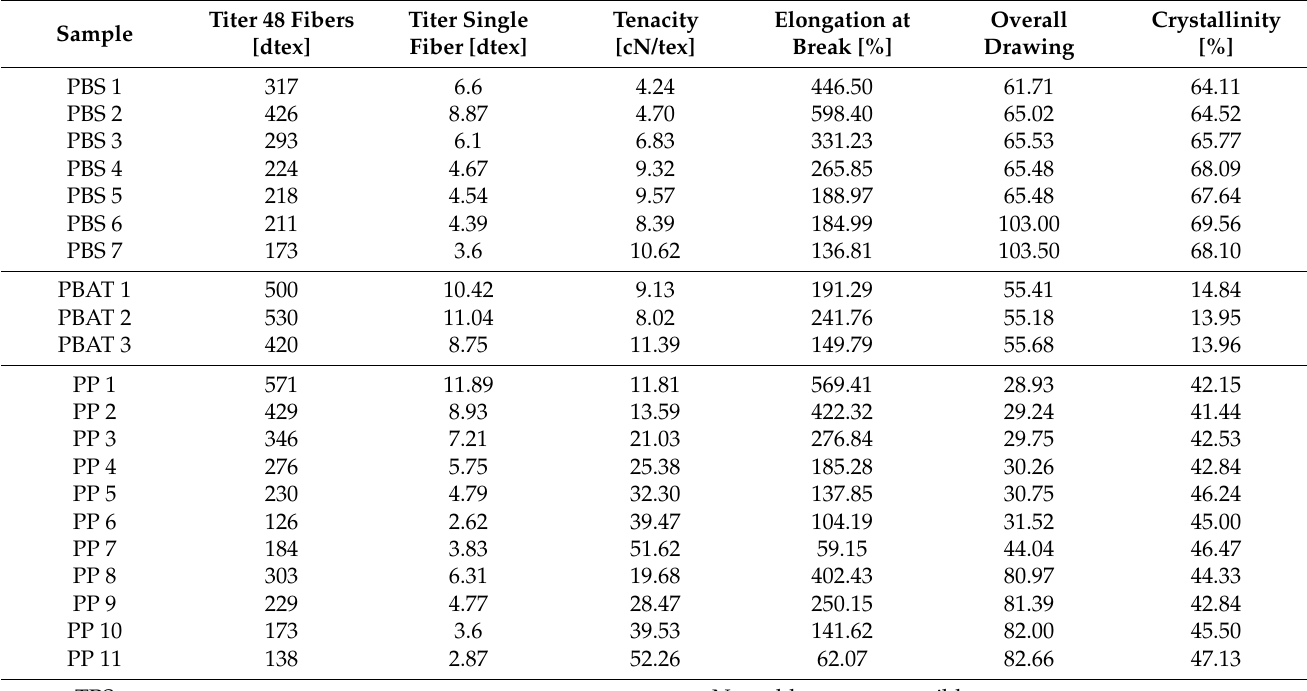
Figure 16. Overall draw ratio and crystallinity over fiber fineness for three polymers. Table 6. Summary of the properties of the different polymer fibers discussed in this study. The polymer samples are prepared as described in Table 2.